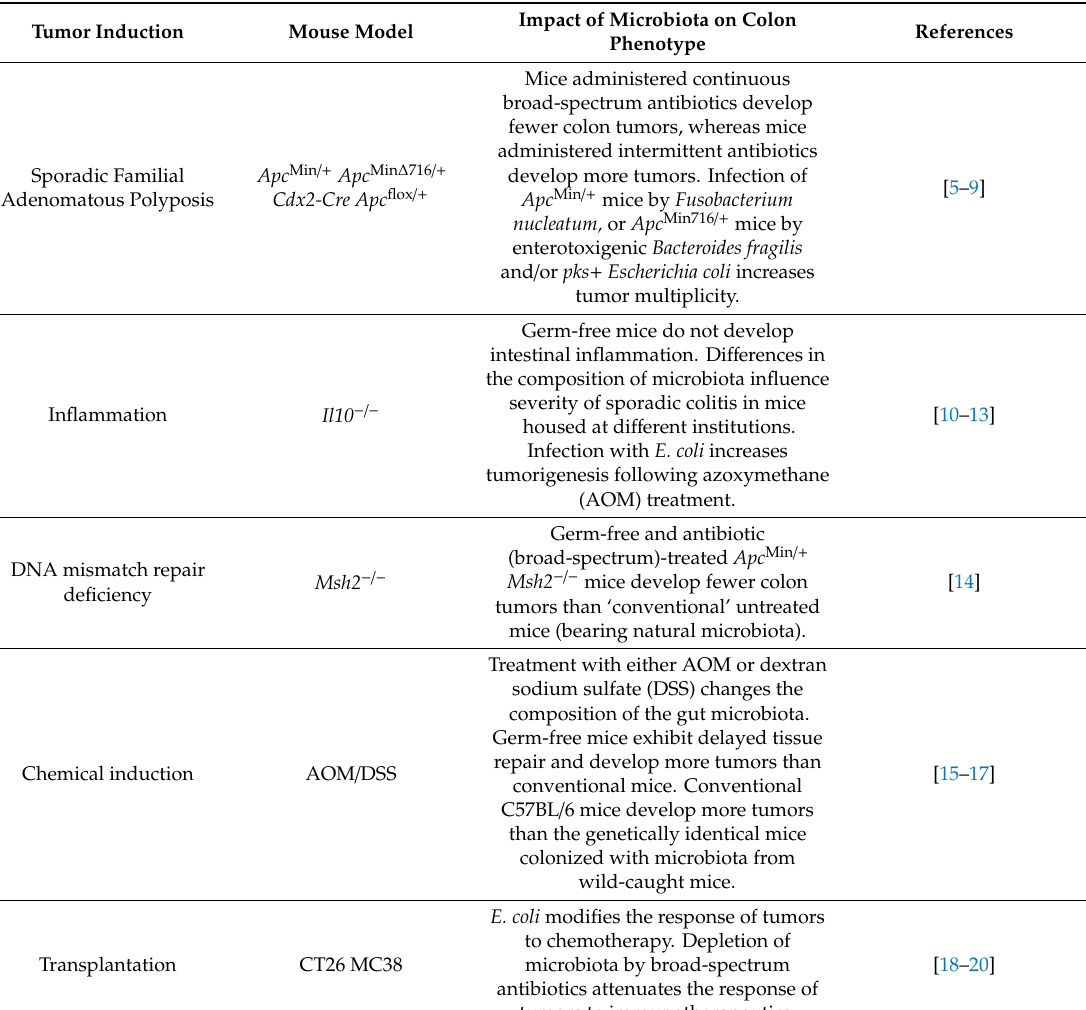
Table 1. Influence of microbiota on disease phenotype in common mouse models of CRC (colorectal